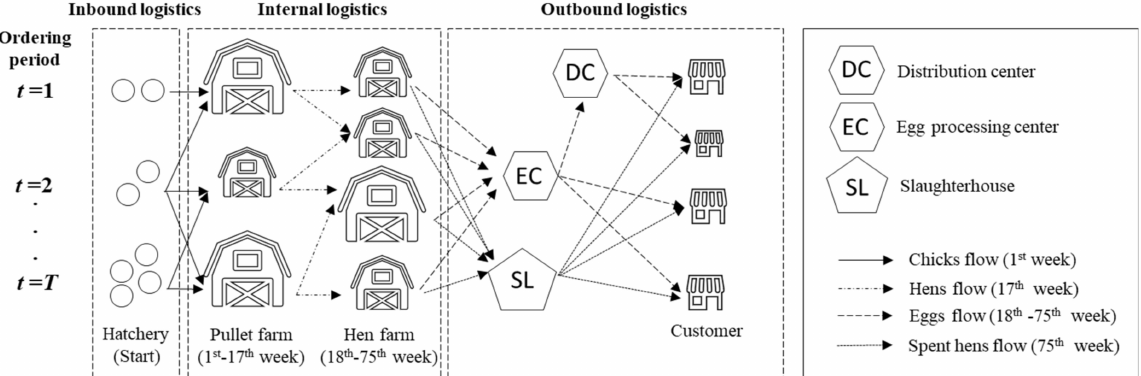
Figure 1. Flowchart of hen and egg production in the case study